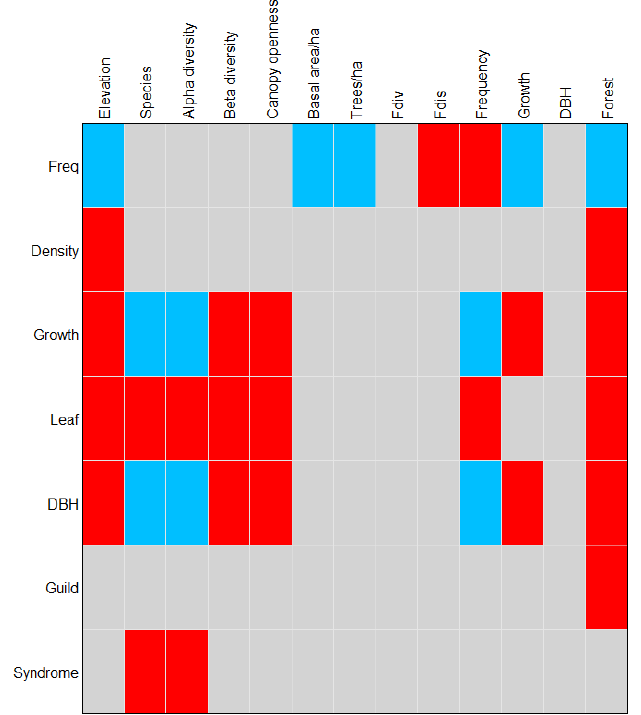
Figure 6. The relationship between trees functional traits and habitat variables. Colors represent the strength of interactions (shading) and their direction. Red indicates a positive association and blue indicates a negative association. The scale bar indicates the values of fourth-corner coefficients. Elev elevation, TD tree density. See Table 2 for definition of traits. Table 6. P values and type of correlation used in the Four Corner analysis between the functional traits of the species and the environmental variables, based on the species abundance matrix in each of the determined forest plots.